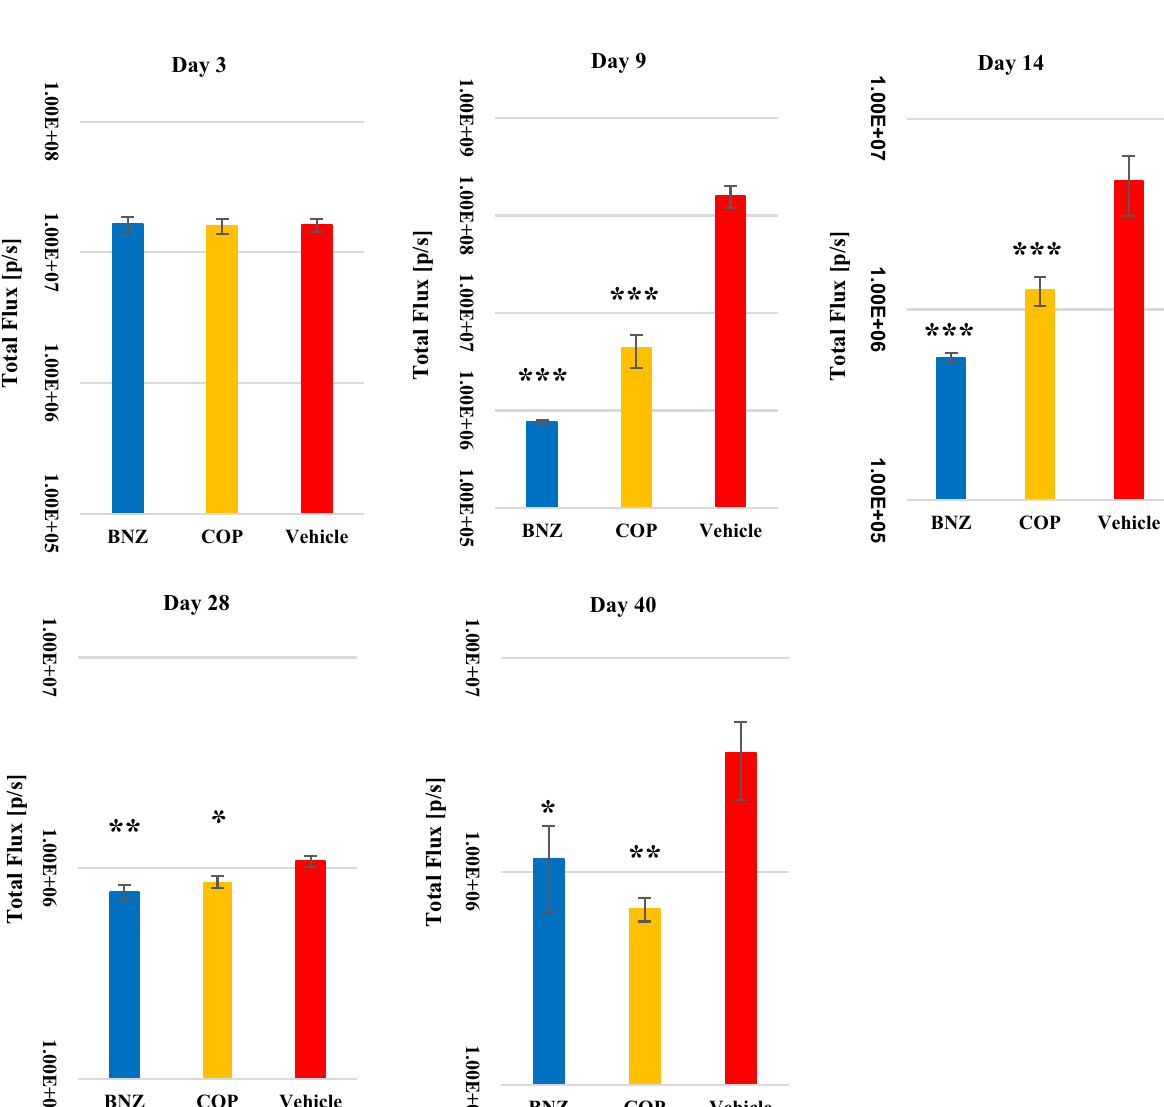
10 3 trypomastigotes and treated with coptisine chloride × p.o.); negative control is the drug solvent. Bioluminescence × 10 7 in ×